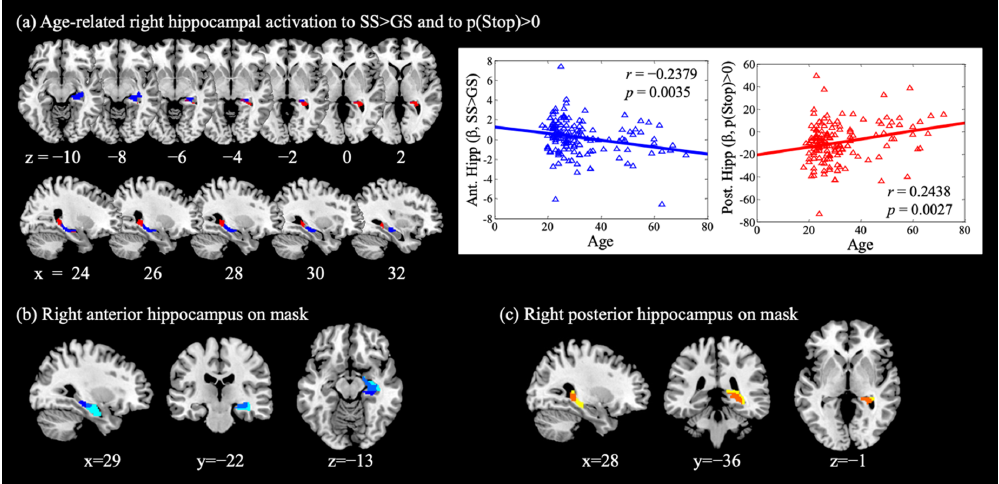
Figure 2. Hippocampal activations during cognitive control. ( a ) Right anterior hippocampus (blue) showed activation during SS > GS in negative correlation with age; right posterior hippocampus (red) showed activation to p(Stop) > 0 in positive correlation with age. These clusters were overlaid on ( b ) with the overlap shown in orange. the right anterior hippocampus mask (MNI coordinate anterior to y = − 22, cyan, as defined in Zeidman with the overlap shown in and Maguire [30]; overlap shown in cobalt), and on ( c ) the right posterior hippocampus mask (yellow) with the overlap shown in orange.